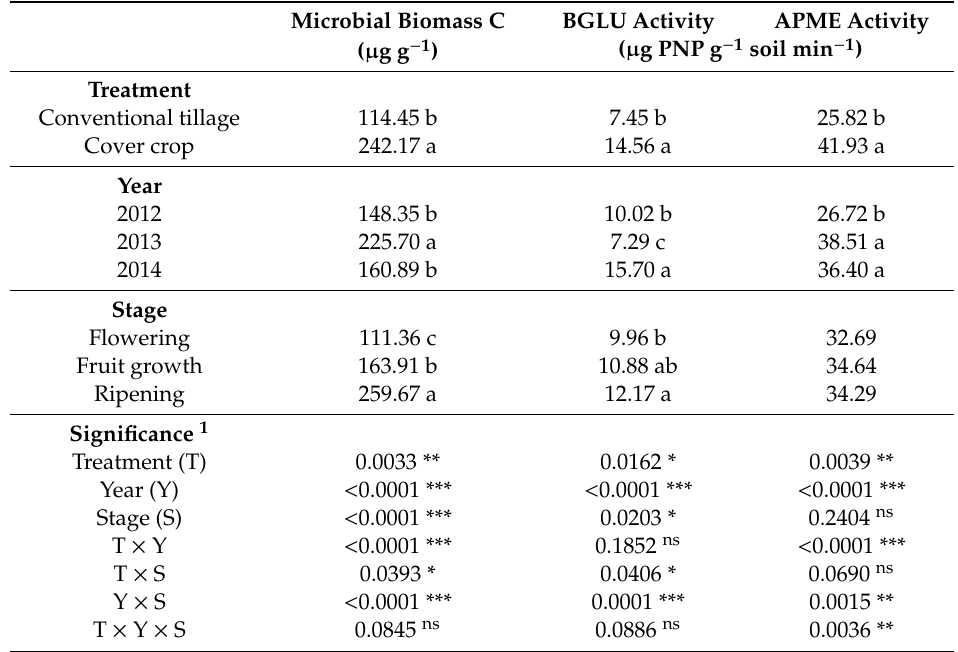
Table 3. E ff ect of the soil management system (treatment), growing season (year), phenological phase (stage), and all their interactions on microbial biomass C, β -glucosidase (BGLU) and alkaline phosphomonoesterase (APME) activity of